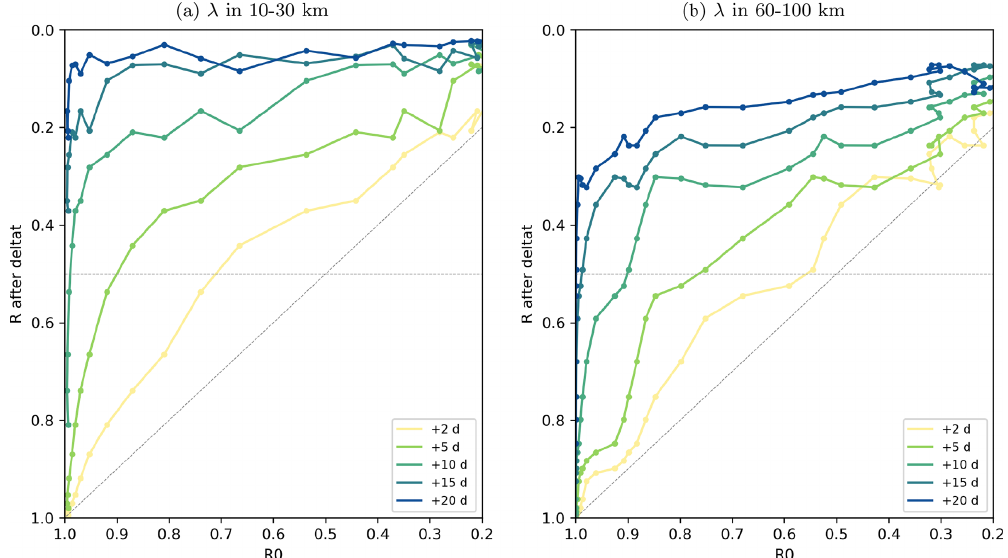
Figure 19. Mean wavenumber spectral coherence ratio R of the ensemble forecast as a function of the coherence of the ensemble initial conditions, for different forecast time lags ( + 2, 5, 10, 15, 20d), computed from hourly SSH in experiment ENS-CI. The mean ratio R is taken over scales of (a) 10–30km and (b) 60–100km. A gray horizontal line marks the value of the coherence ratio R at 0.5, at which we consider the decorrelation of the ensemble members as effective. The R 0 = R forecast line is also marked in gray.